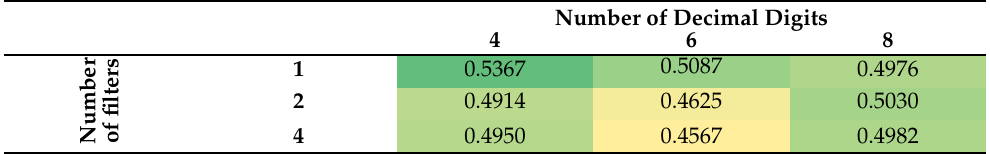
Table 1. HCBR-balanced accuracy (PREDICTION) for a single subject depending on the number of decimal digits and xDAWN filters a